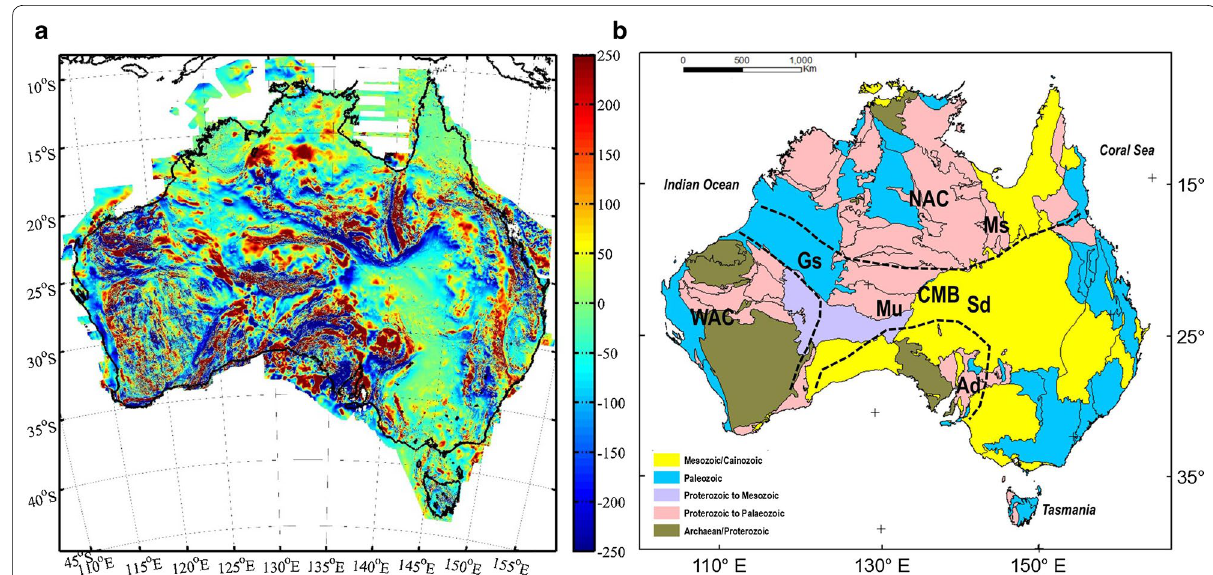
Fig. 1 a Fifth edition of the Australia magnetic anomaly map (Milligan et al. 2010). The original (41,876 50,592) grid at an 80-m interval including × null values was resampled at an interval of 0.008 ( 1/120) degrees into the (4190 5062) grid used for this study with the anomaly statistics listed = × in Table 3; b tectonic boundary map of Australia modified from Blake and Kilgour (1998). The black dashed lines mark the major cratons of Australia. Selected feature annotations include CMB Central Mobile Belt, NAC North Australian Craton, WAC West Australian Craton, Ad Adelaide block, Gs Great Sandy Desert, Ms Mt. Isa inlier, Mu Musgrave Block, Sd Simpson Desert